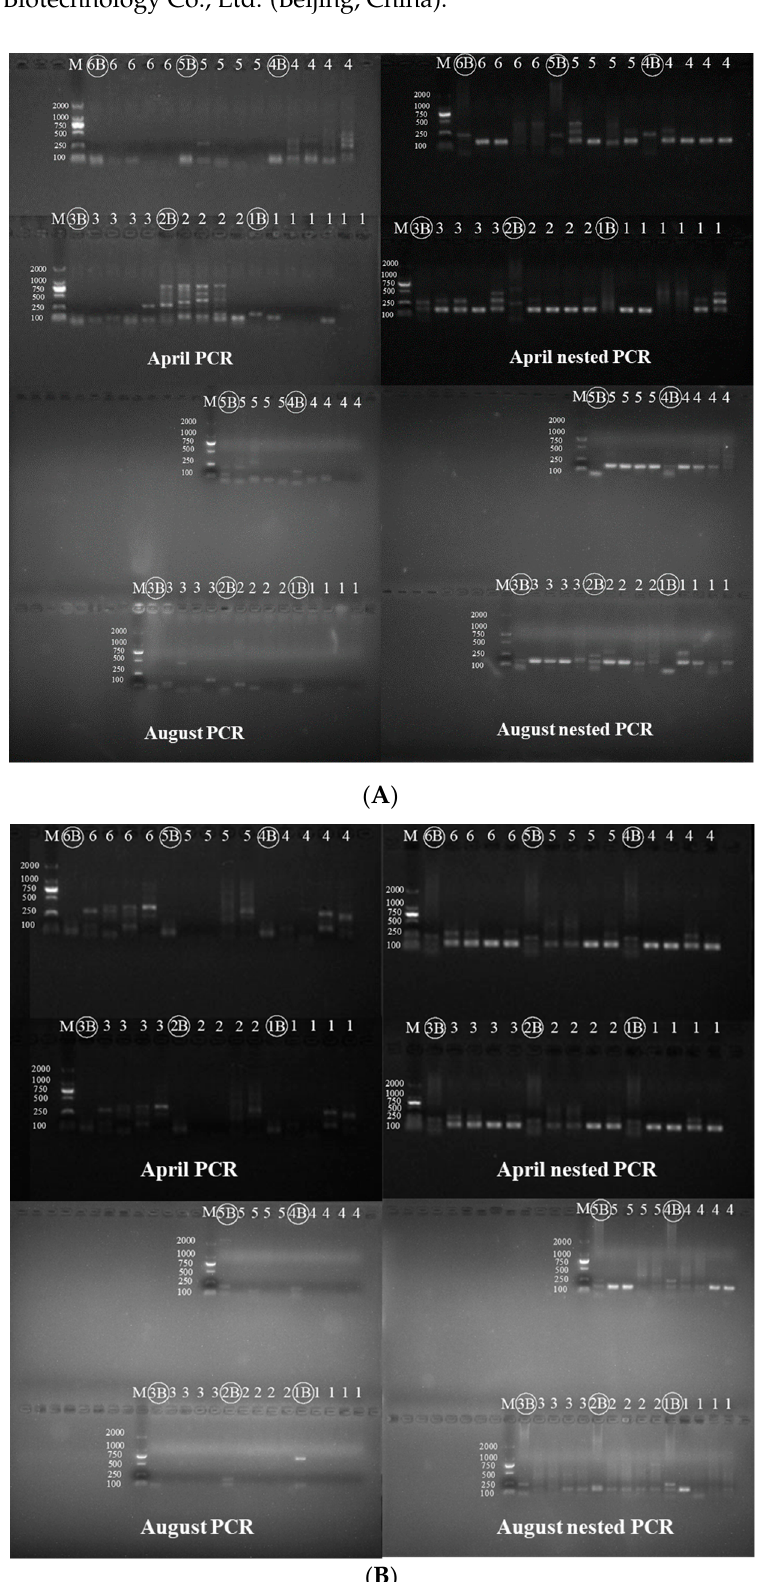
Figure 3. PCR and nested PCR results of water eDNA sample for San Cha River ( A ) and Miao Gou River ( B ). (M, marker; B, blank; 1-6: last number of site name in Table 1).